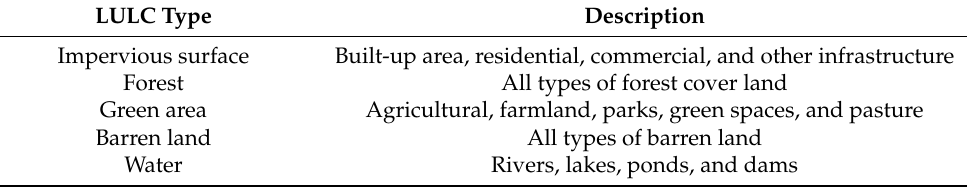
Table 2. LULC classification